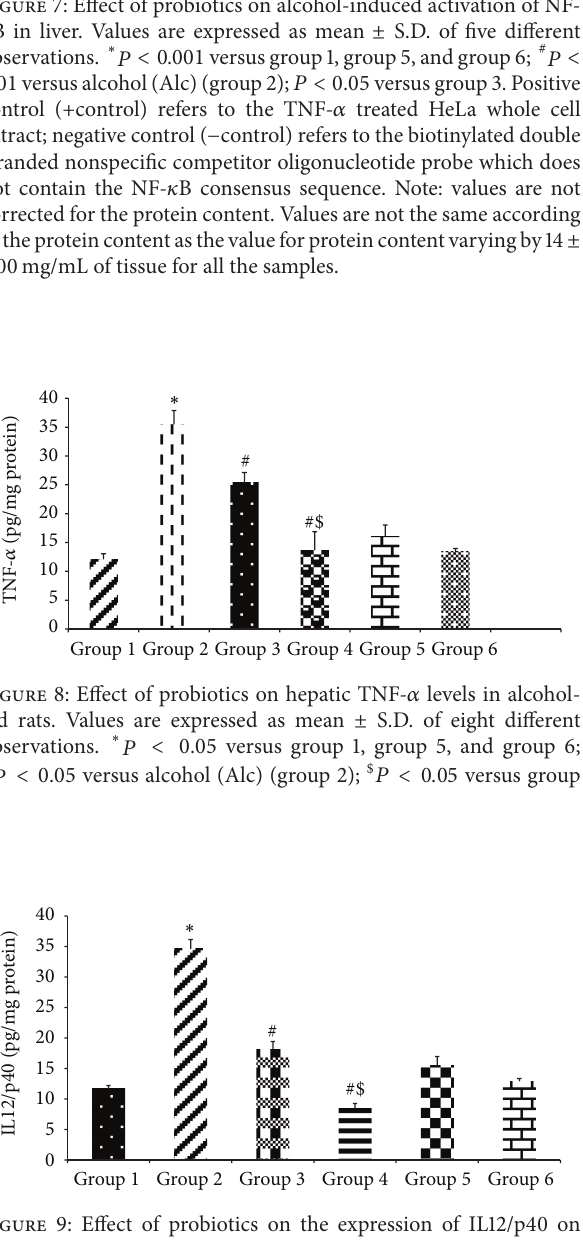
Figure 9: Effect of probiotics on the expression of IL12/p40 on alcohol-induced liver. Values are expressed as mean ± S.D. of eight different observations. ∗ 𝑃 < 0.05 versus group 1,group 5, and group 6; # 𝑃 < 0.05 versus alcohol (Alc) (group 2); $ 𝑃 < 0.05 versus group